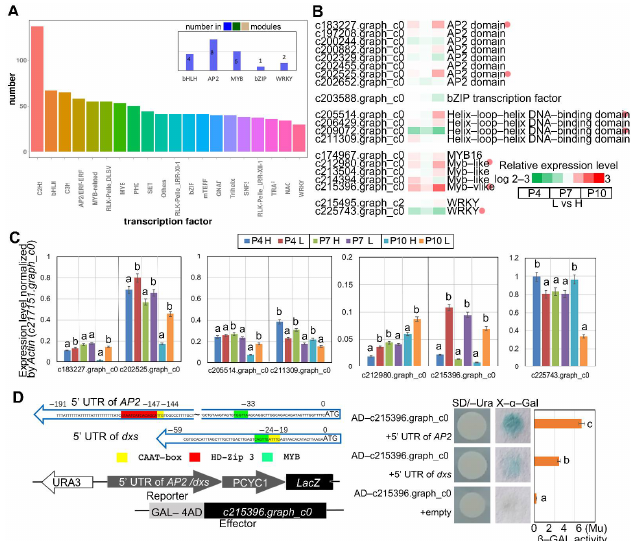
Figure 5. Transcript factors associated with α - and β -pinene biosynthesis. ( A ) Histogram of tran- scription factor family members annotated based on the unreferenced transcriptome data and 3 co-expression modules (MEblue, MEdarkgreen, MEtan) related to pinene content. ( B ) Expression profiles of AP2 , bZIP, MYB and WRKY transcription factors as per the RNA-seq data. ( C ) Results of RT-PCR about the selected AP2 , bZIP, MYB and WRKY transcription factors. The expression levels were standardized by the expression level of Actin ( c217151.graph_c0 ). Four biological du- plicates were showed in the experiment. ( D ) The 5 (cid:48) UTR fragments of AP2 ( c183227.graph_c0 ) and dxs ( c193143.graph_c1 ) were constructed in the pLacZi plasmid, which were co-transformed with GAL4-AD-MYB ( c215396.graph_c0 ) plasmid into YM4271 strain. The implementation of X-gal staining with three technical replicates provided proof of the β -galactosidase activity. All bars represent means ± s.d. The columns labeled with different letters indicate a significant difference in p value < 0.05 according to Duncan’s